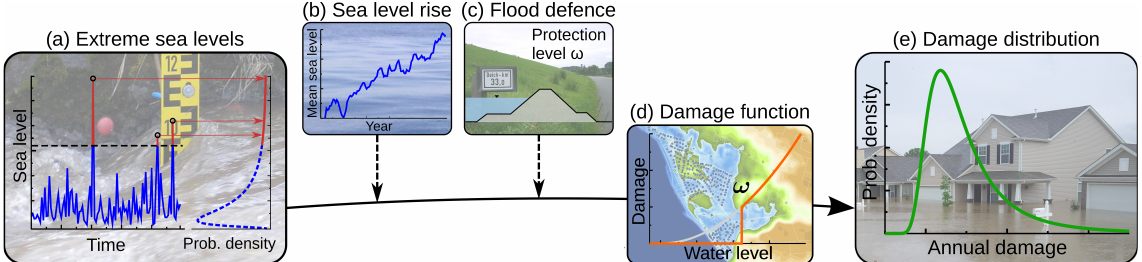
Figure 1. From extreme sea levels to damage. (a) The analysis of extreme sea levels provides parameter estimations for the generalised Pareto distribution. (b) The distribution of sea levels is influenced by mean sea level rise. (c) Flood defence measures, such as dykes, set the threshold below which any damage is prevented. (d) The distribution of extreme sea levels is combined with the corresponding damage via a damage function, providing the total damage in the region under study at a certain maximum flood level. (e) From the resulting distribution of total annual damage the expected annual damage and its standard deviation can be derived. (Photographs: “Ilmpegel Ilmenau” by Michael Sander (2006), “Sea” by Dedda71 (2008), “Kilometermarkierung Deich” by Georg HH (2006), and “Nashville Flood” by Eric Hamiter (2010) from Wikimedia Commons –